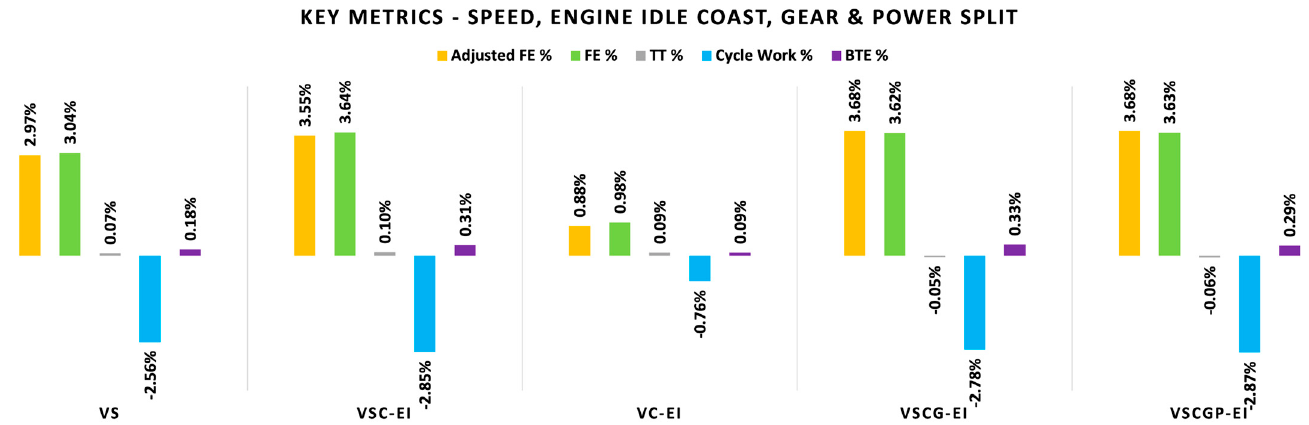
Figure 8. Key metrics showing the comparison of benefits along with cycle work and BTE for the complete set of problem including speed, coast, gear, and power split management. This scenario is with engine idle coast.